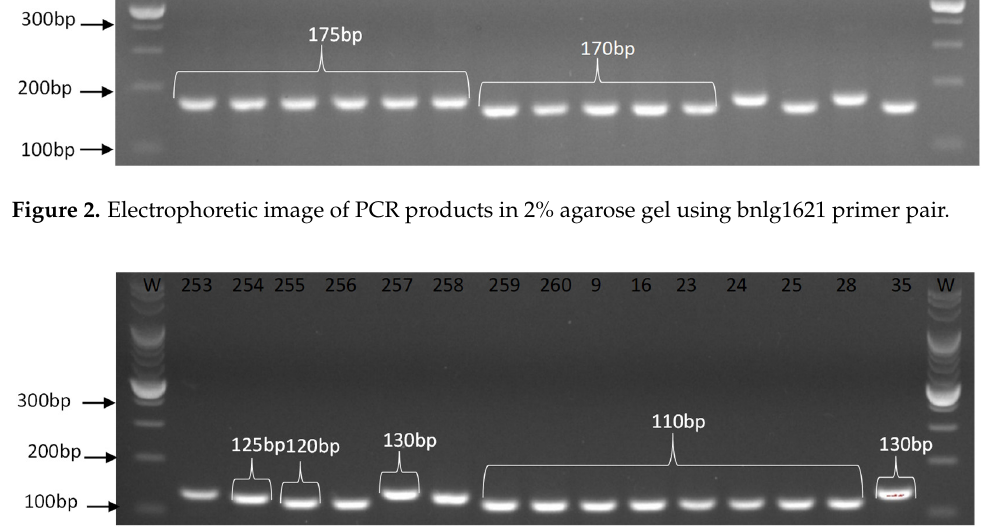
Figure 3. Electrophoretic image of PCR products in 2% agarose gel using umc2059 primer pair.